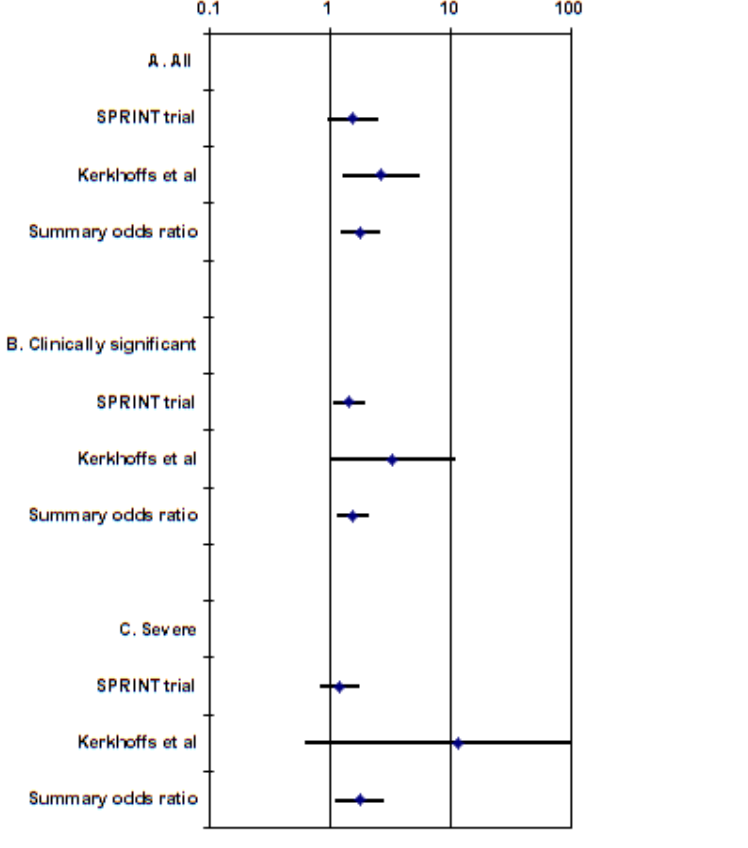
FIGURE 3. ORs of all bleeding complications, clinically significant bleeding complications, and severe bleeding complications in patients receiving pathogen-reduced vs. non–pathogen-reduced platelets in the two RCTs that assessed bleeding daily using trained assessors[14,37]. The bleeding complications recorded in the entire study period (including both the transfusion and surveillance period) of the SPRINT RCT[32] were reported separately[37]. The figure also shows the summary OR (95% CI) of bleeding complications across the two RCTs[14,37], which is statistically significant ( p < 0.05) in all three analyses: 1.8 (1.2–2.7) for all bleeding complications, 1.5 (1.1–2.1) for clinically significant bleeding complications, and 1.8 (1.1–2.8) for severe bleeding